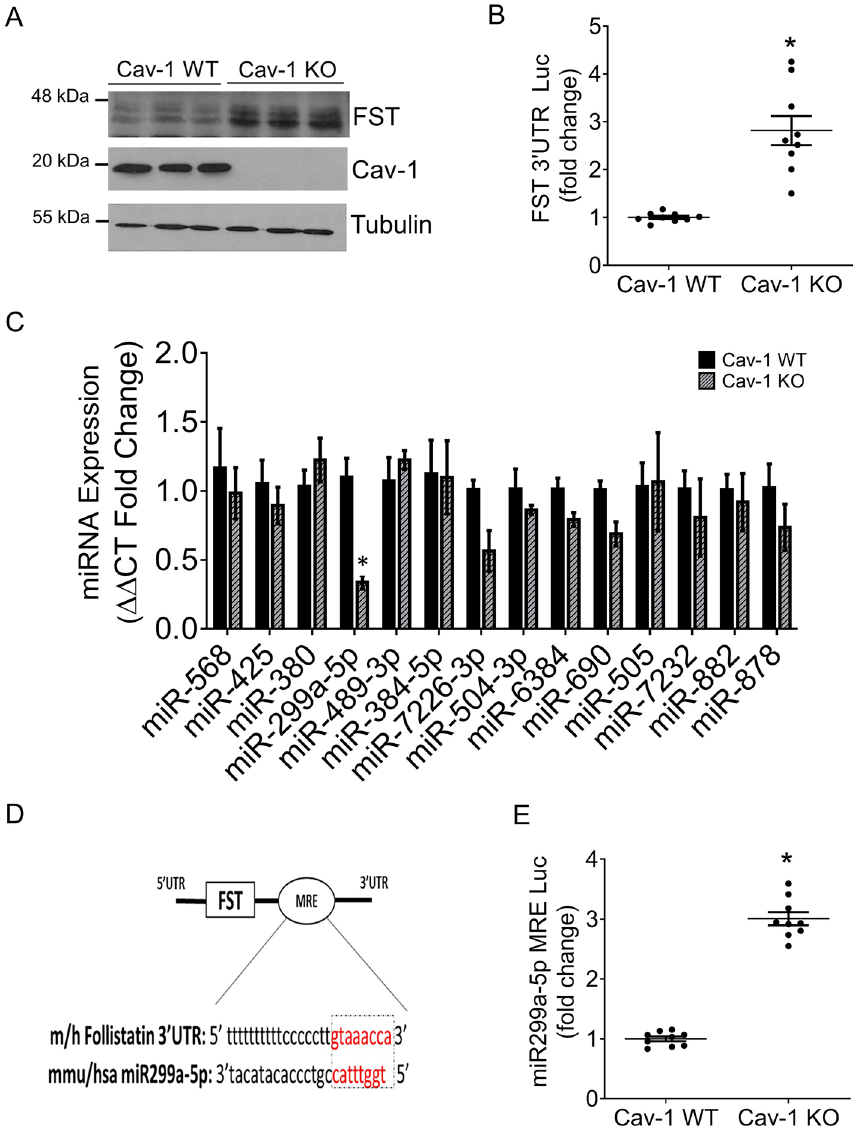
protein was increased in cav-1 KO MC (n = 9, *p < 0.05). ( B ) Stability of the FST 3 ′ UTR, as assessed by